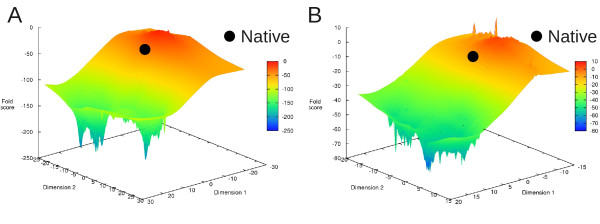
Folding scores for near-native sequences threaded through the conformation of the SAP protein are shown. The score distribution is shown as a landscape, with the percentage of the negative native score (i.e -Sgapnative, see eq. 15) on the Z axis and coordinates in high-dimensional sequence space projected onto the X and Y axes via Sammon mapping. Smaller scores denote more stable sequences (in blue), with larger scores being less stable (becoming progressively more red). The native sequence is marked by a black dot. A) The score distribution for the informational scoring function. B) The score distribution for the physics-based scoring function.